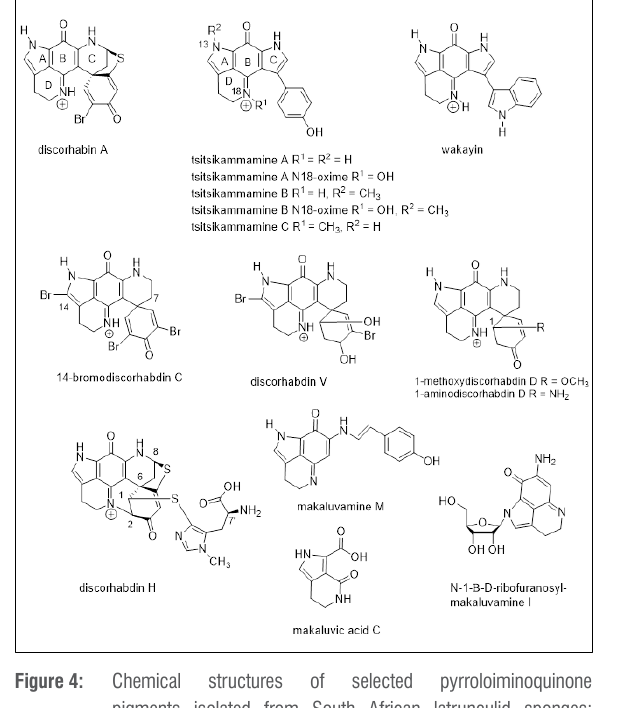
Figure 4: Chemical structures of selected pyrroloiminoquinone pigments isolated from South African latrunculid sponges: tsitsikammamine C from the sponge Zyzzya fulingosa and wakayin from a Clavelina ascidian .